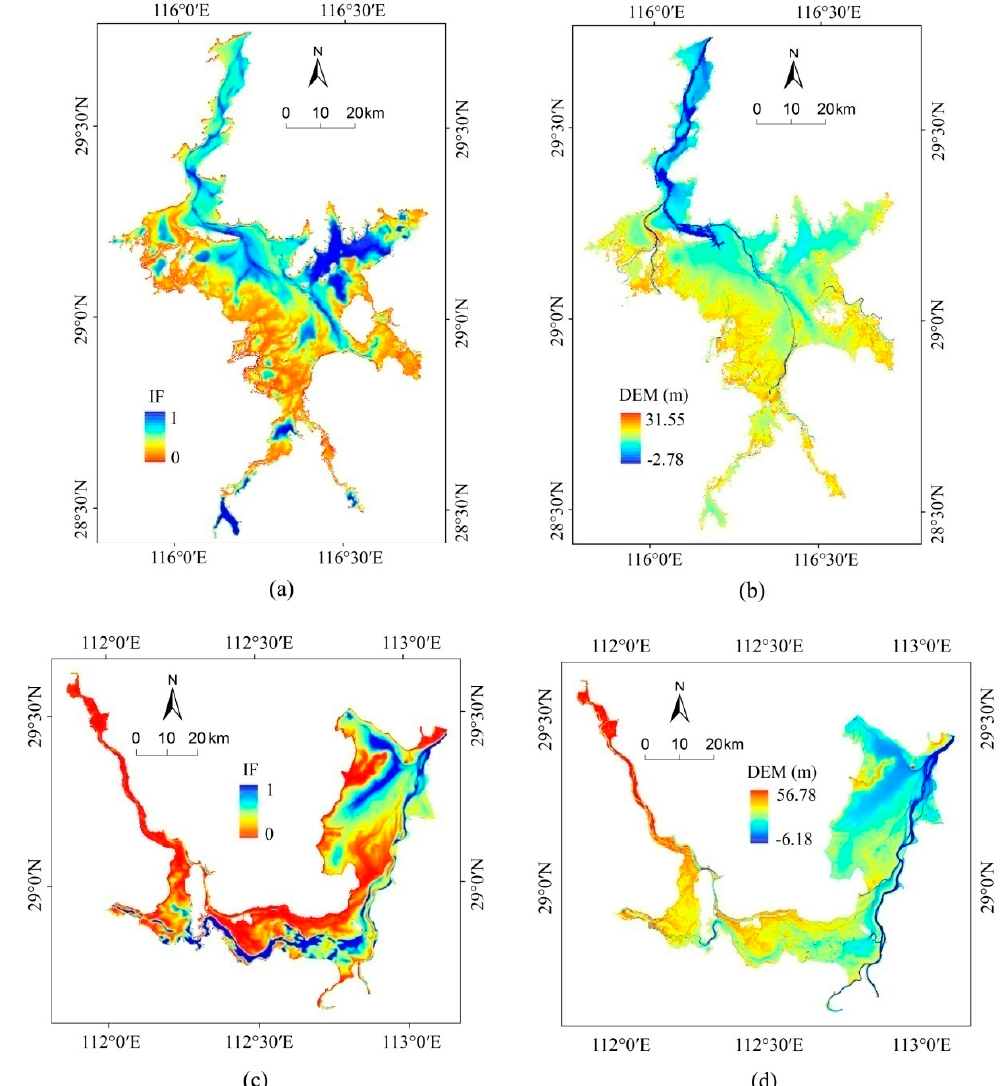
Figure 5. ( a – d ) Maps of the estimated multi-year mean inundation frequencies ( left column ) and bottom topography ( right column ) for the two lakes during 2000–2011.